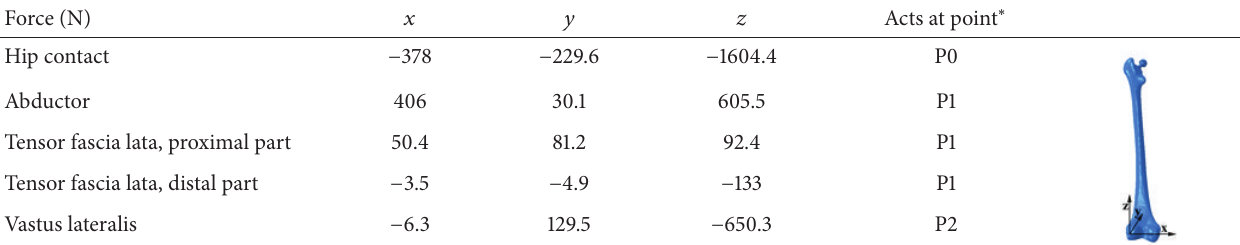
Table 2: Normal walking-frame of maximum contact force [32,